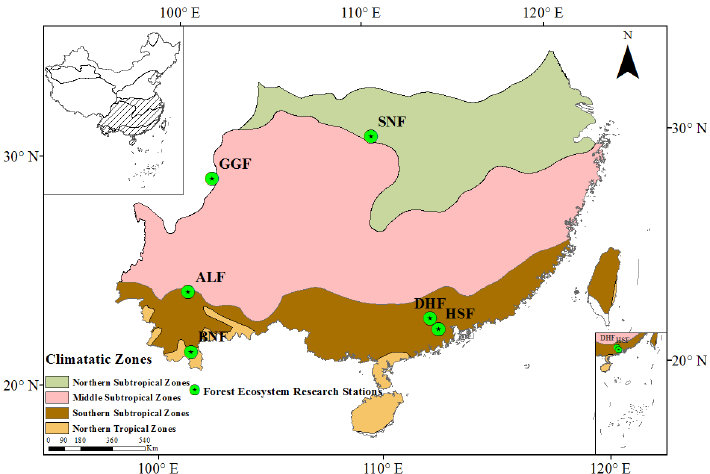
Figure 1. Map of the study sites in Southern China.